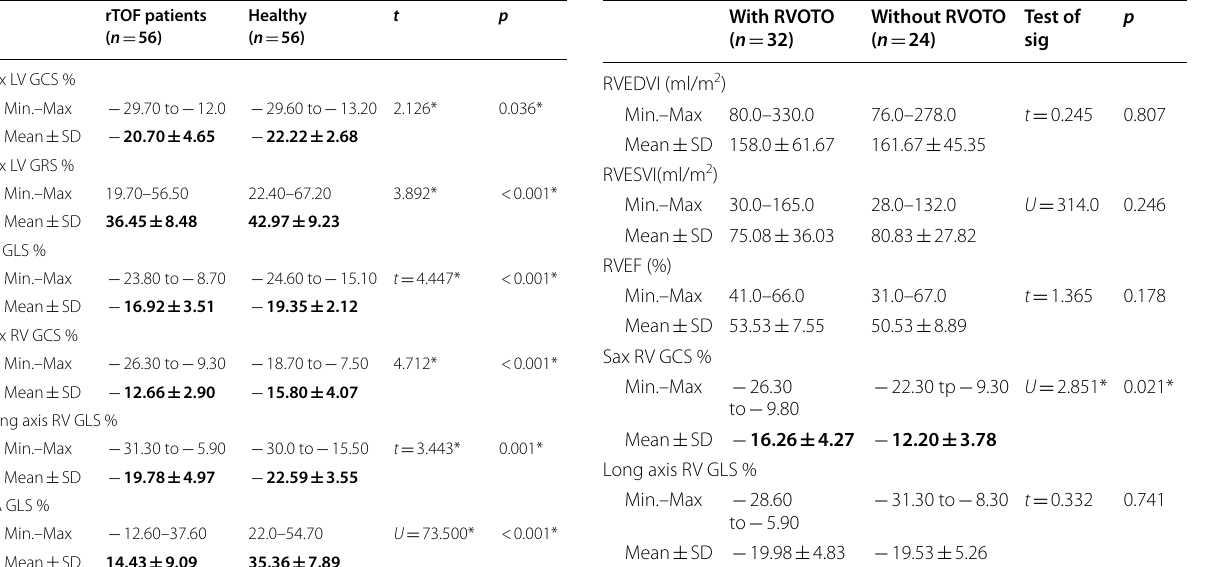
Table 9 Comparison between the two studied groups (56 rTOF patients and 56 healthy volunteers) according to the different CMR FT parameters